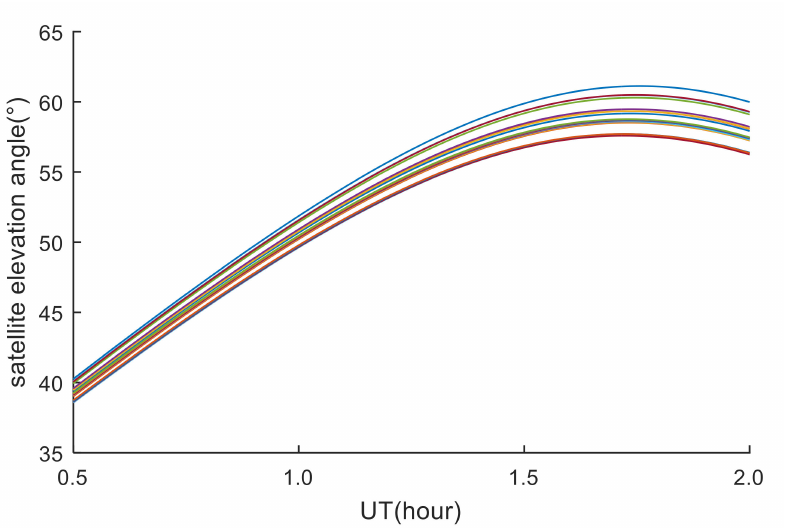
Figure 2. Elevation angle between GPS stations and PRN05 satellite. Lines with di ff erent colors represent di ff erent GPS stations.